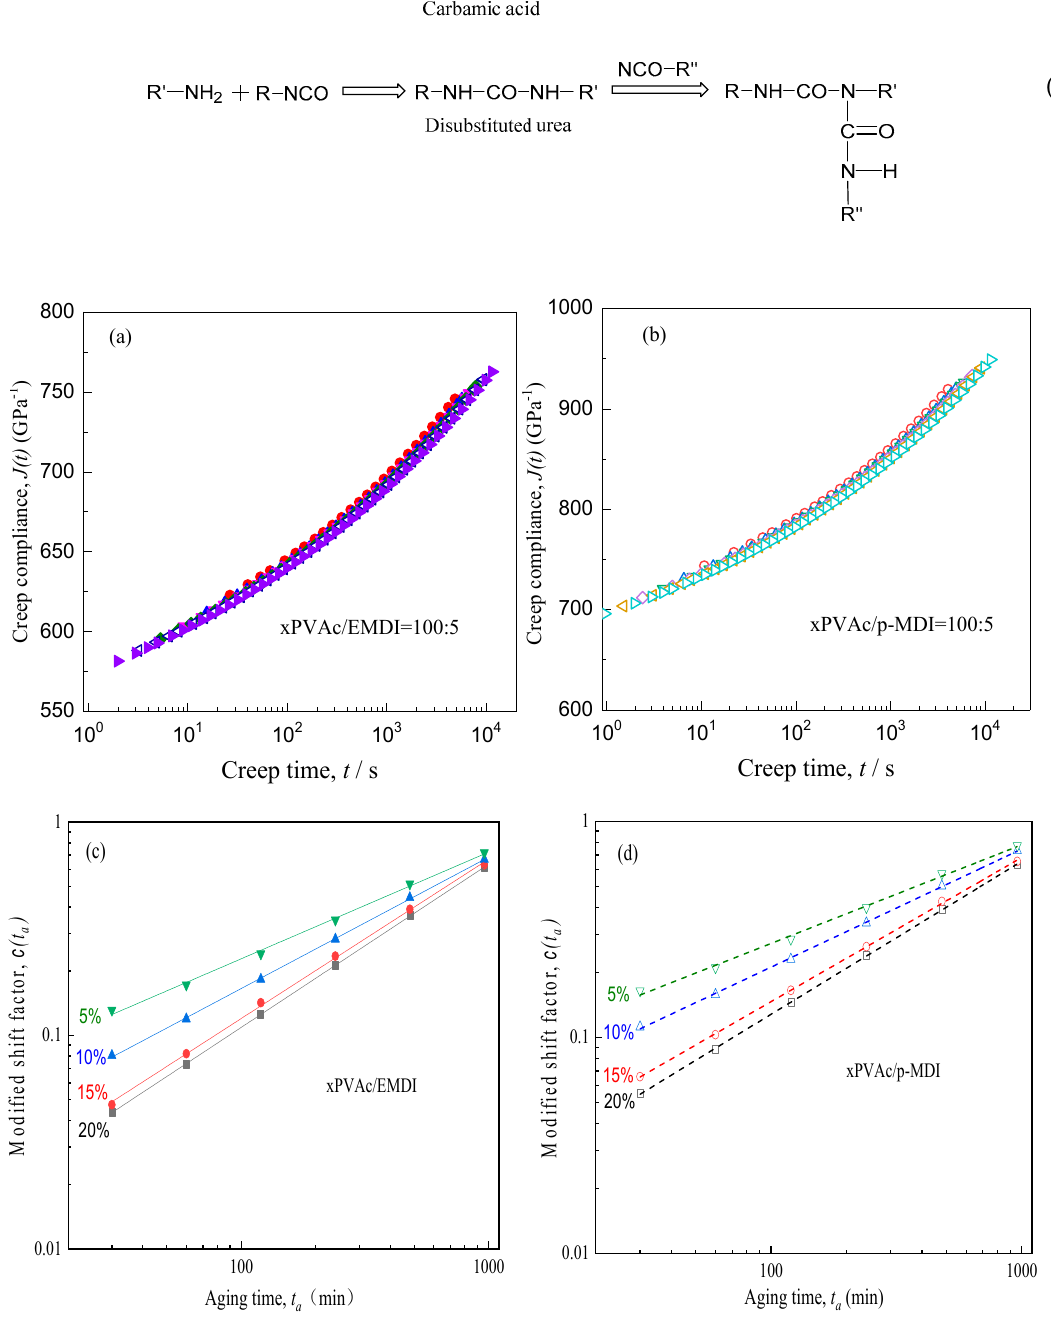
Figure 6. Creep master curve and shift factor of EPI films with different crosslinkers.